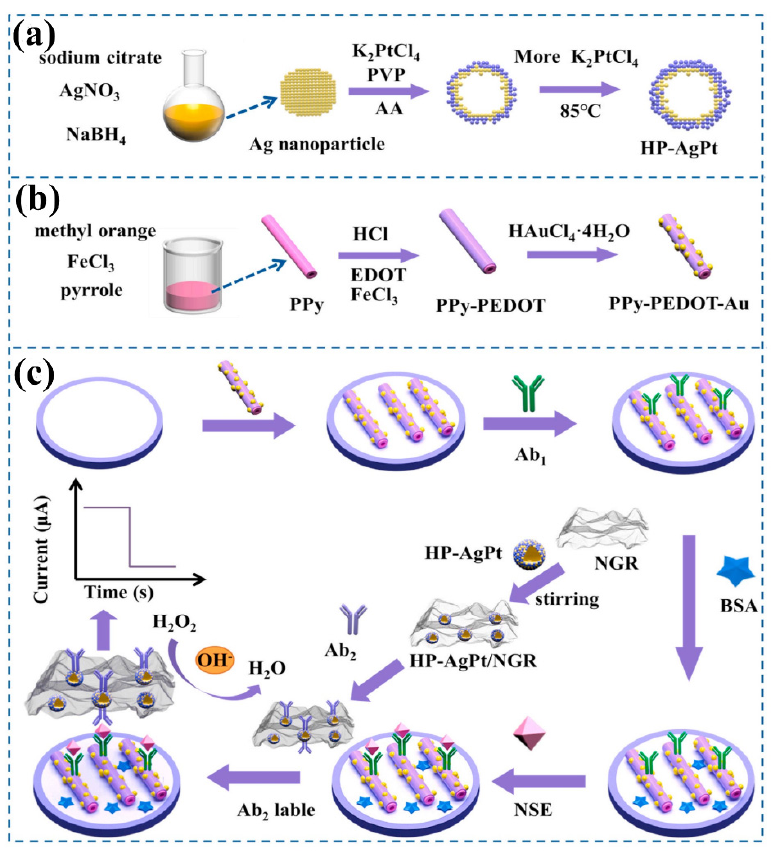
Figure 7. The schematic pathway for the synthesis for HP-Ag/Pt ( a ) and PPy-PEDOT-Au ( b ) and the steps involved in immunosensor fabrication ( c ). Reproduced with permission from [72].